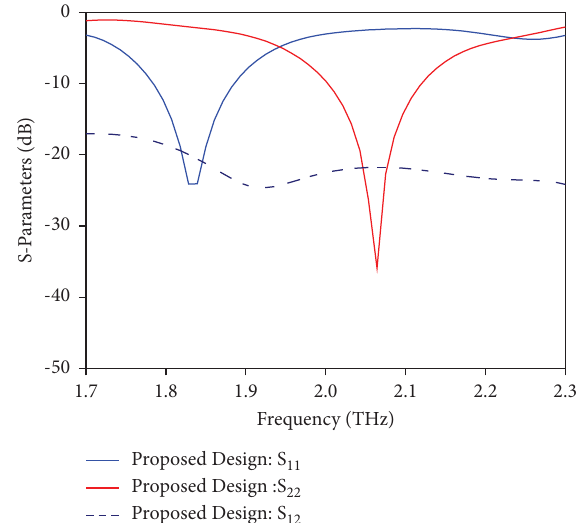
Figure 4: Simulated S-parameters of the proposed